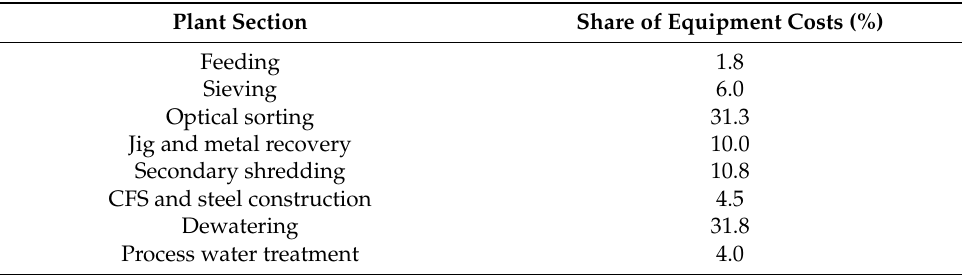
Table 17. Capital expenditure for equipment per plant